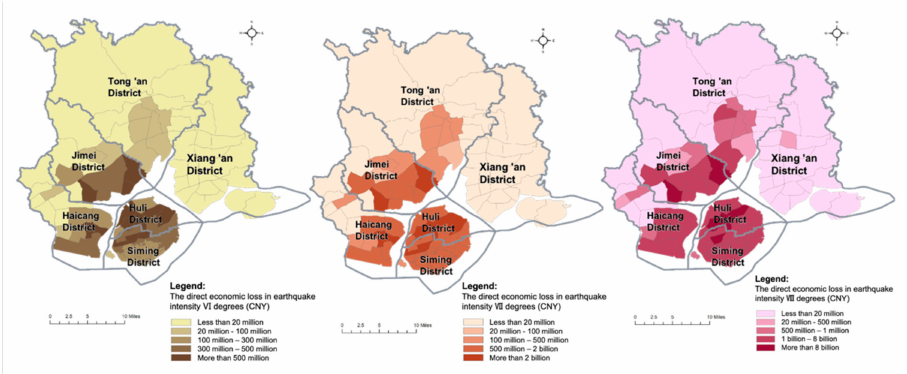
Figure 3. The distributions of direct economic losses in three earthquake